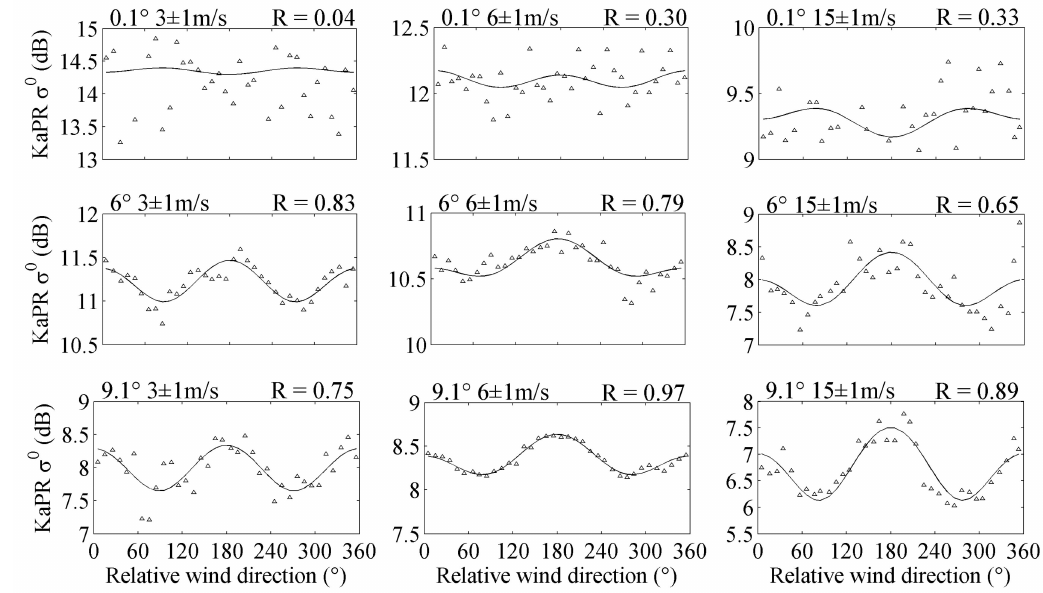
Figure 7. Wind direction signal of KaPR σ 0 for different wind speeds and incidence angles. Symbols and lines are as in Figure